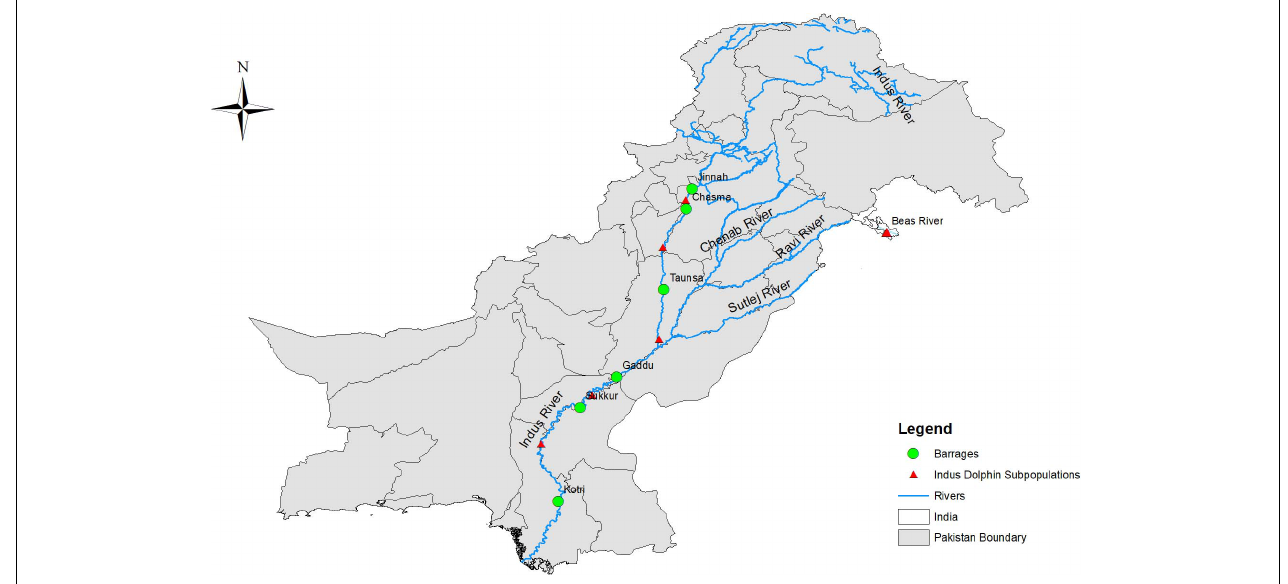
FIGURE 2 | The Indus River Dolphin